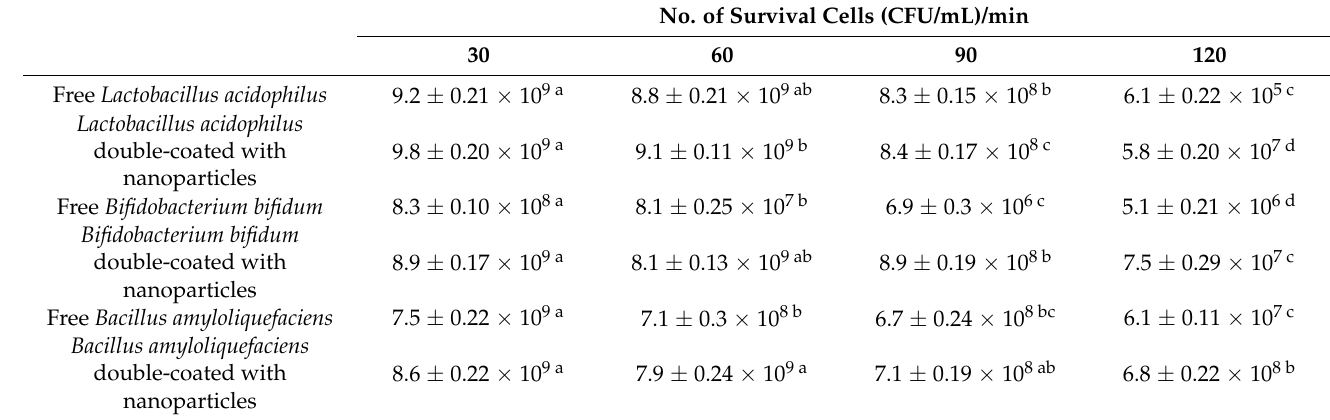
Table 3. Cell survivability of free and nanoparticle-double-coated multi-strain probiotics (log CFU/mL) after treatment in activated gastric juice followed by activated intestinal juice with bile salt. No. of Survival Cells (CFU/mL)/min 30 60 90 120 Free Lactobacillus acidophilus 9.2 ± 0.21 × 10 9